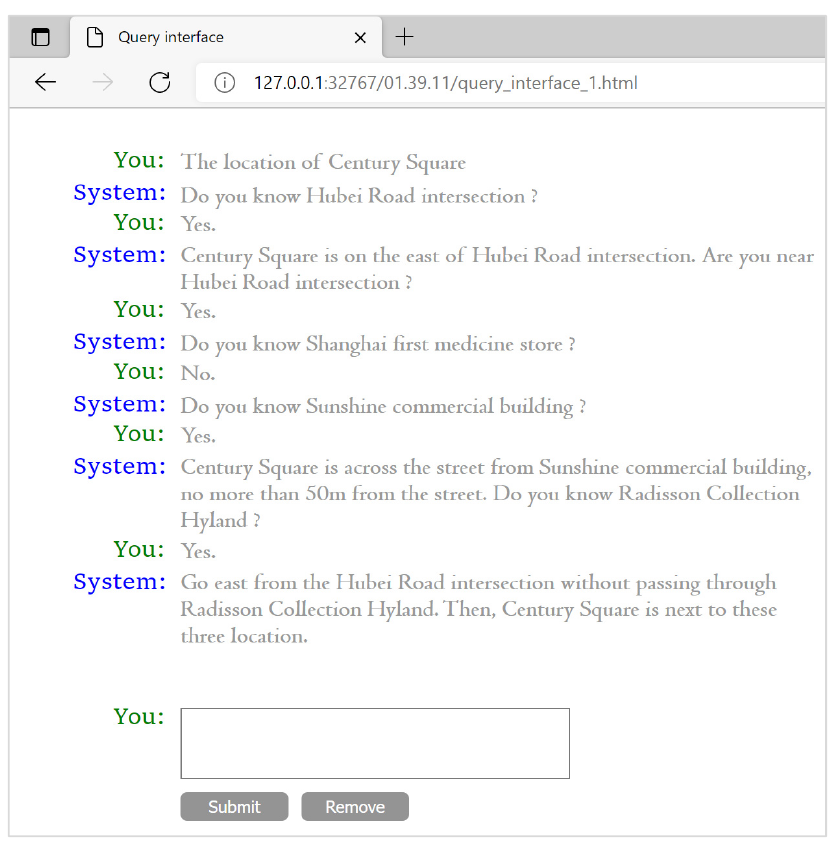
Figure 9. Positioning results of single spatial assertion. ( a ) is the schematic diagram of the path between every McDonald’s storefront and the metro station. ( b ) is a schematic diagram of screen- ing paths that meet the threshold according to the distance relation.